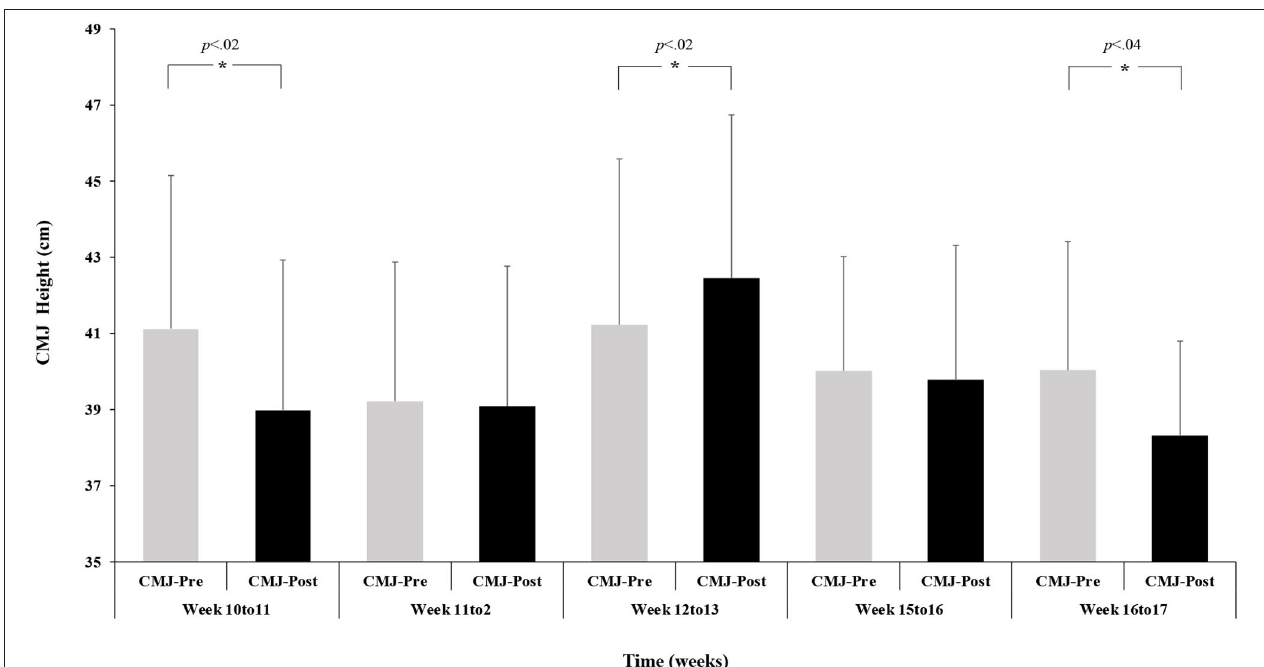
FIGURE 2 | Pre- and post-match countermovement jump (CMJ) height (mean value ± SE) as a function of time (weeks).